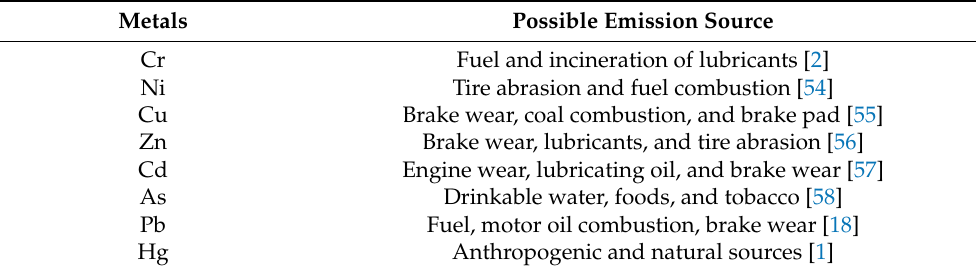
Table 4. Possible sources of heavy metals of this study.